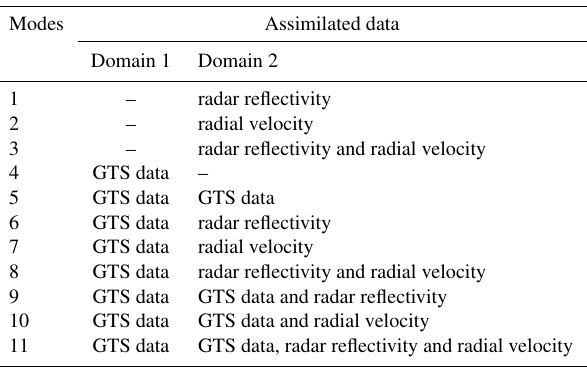
Table 2. Designed assimilation modes with different data combina- tions.